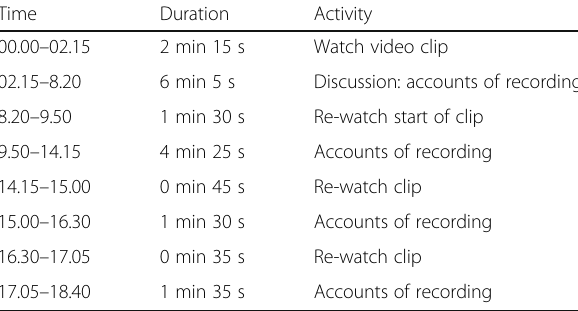
Table 2 Time allocation in the first video club meeting Time Duration